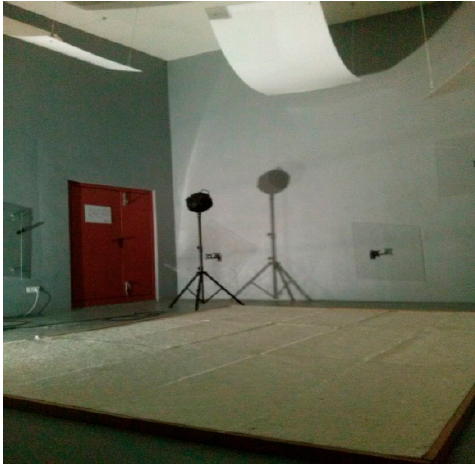
Figure 3. Normalized reverberation chamber at the EPS Gandia at the Universitat Politécnica de València.